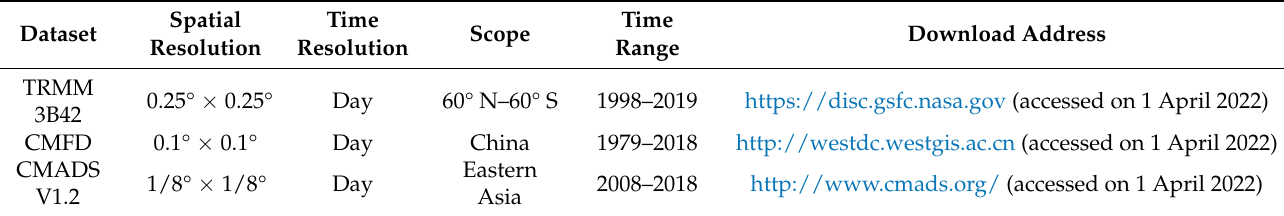
Table 2. Basic information table showing the meteorological precipitation